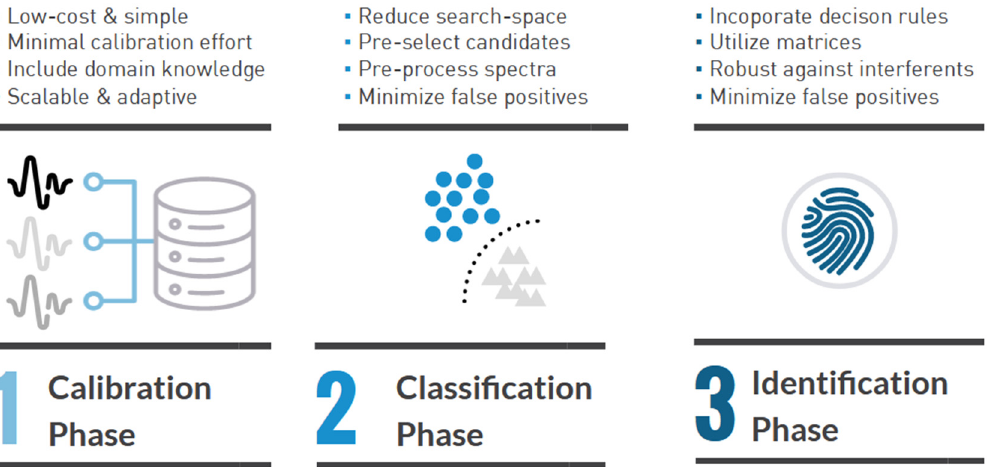
Figure 2. Diagram illustrating the various phases in the applied scheme for NIR-based identification of intact energetic materials in forensic explosives casework using the three-stage TIPb chemometric model.